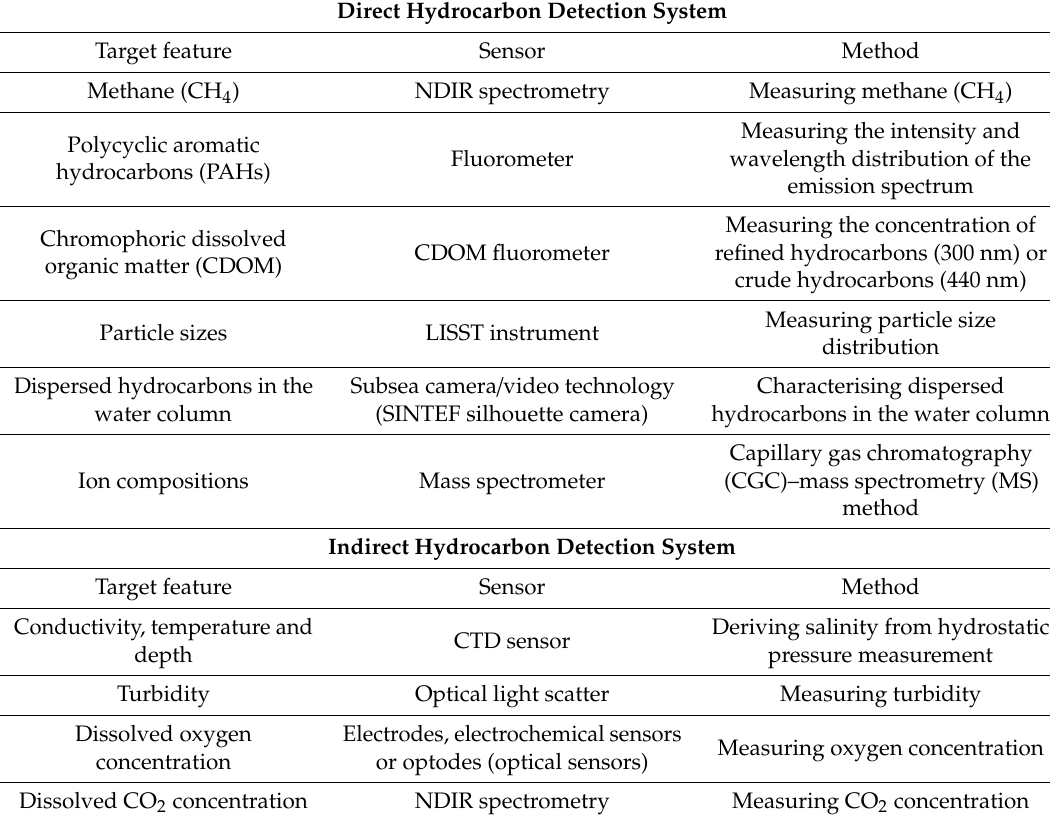
Table 8. Available in-situ methods for hydrocarbon detection in oil spill surveillances, developed from information in